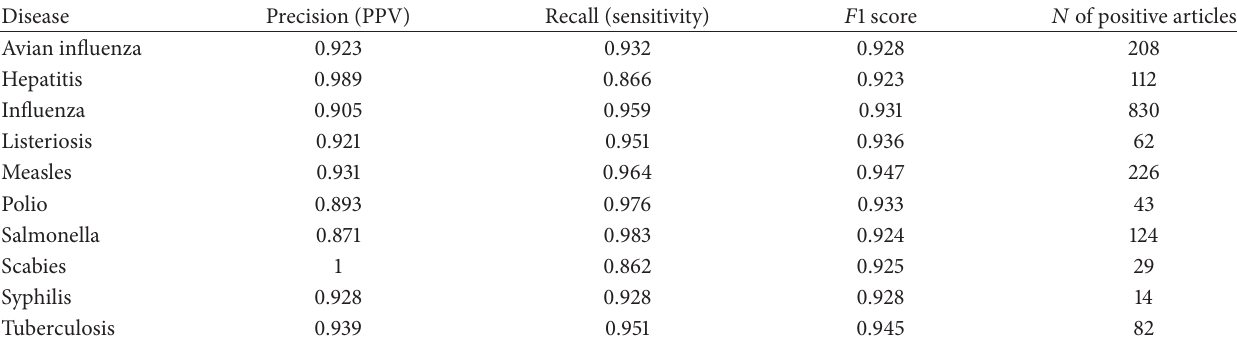
Table 2: GRITS’ top 10 performing disease classifications.